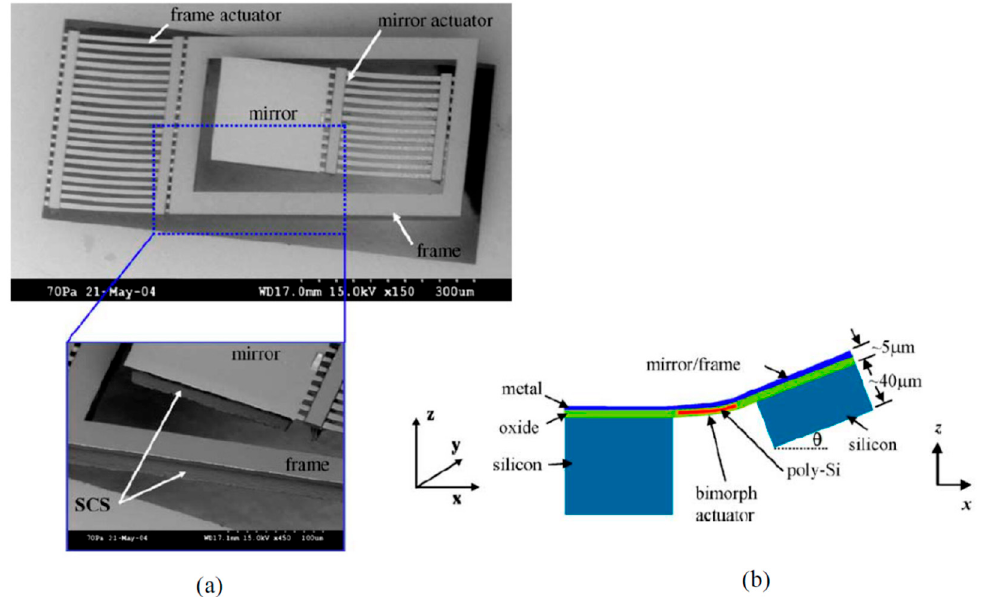
Figure 9. SEM images and structure illustration of an electro-thermal micromirror by bulk post-CMOS microfabrication [71]. ( a ) Micrographs of the mirror and microstructures; ( b ) Illustrative composition of the mirror structures.